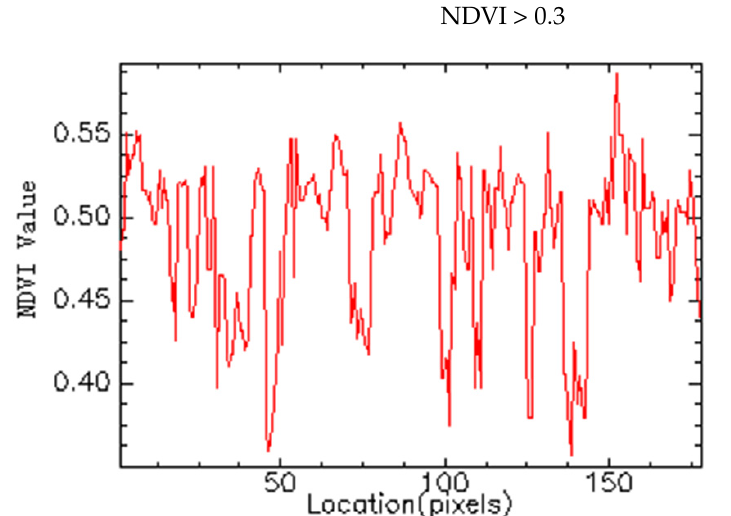
Figure 10. NDVI values of vegetation on the cutting line of an AVHRR/2 image (the location is indicated with the pixel numbers on the line).